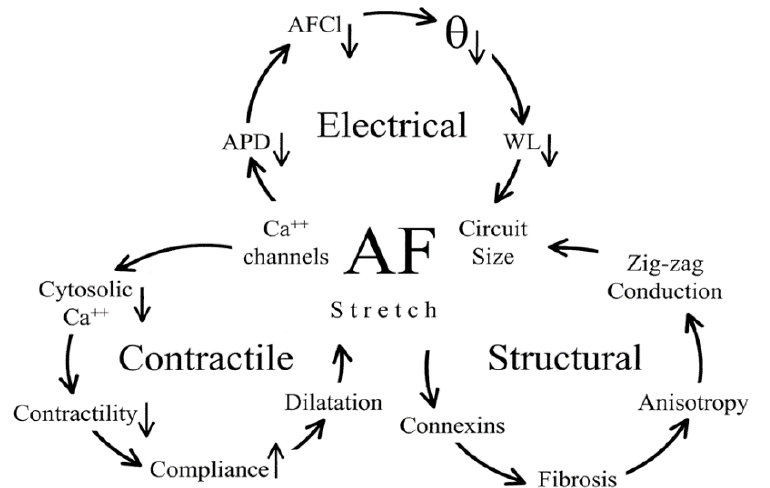
Figure 3. Three proposed positive feedback loops to present the progredient development of atrial remodelling in AF. The electric and contractile remodelling are associated with the downregulation of L-type Ca 2+ -channels which as a result will cause the alteration of the whole Ca 2+ -homeostasis process. The loss of contractility and increase in compliance will induce the stretch of the atrial myocardium, which is considered to be the main inducing factor of the structural remodelling. The resulting intra-atrial circuits due to a reduction in wavelength and increased non-uniform tissue anisotropy and even zig-zag conduction (anatomical basis of re-entry or rotors). Reprinted with permission from ref [10]. Copyright year 2002, Oxford Academic